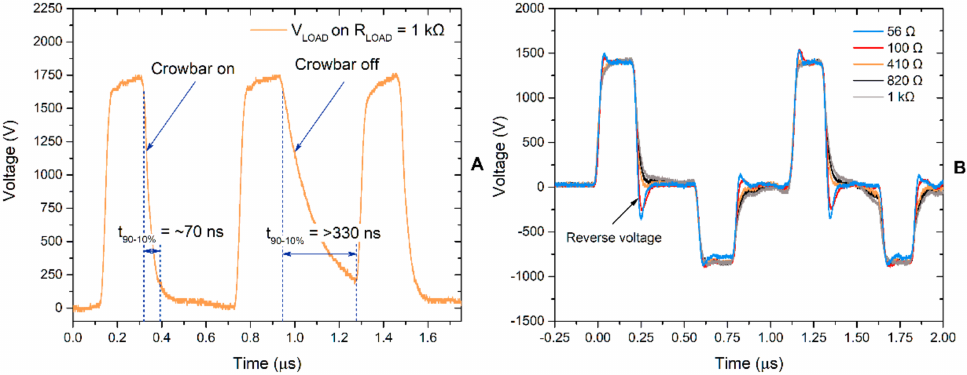
Figure 5. The effects of the crowbar circuit on the pulse waveform ( A ) and the dependence of the output pulse waveform on the load ( B ).